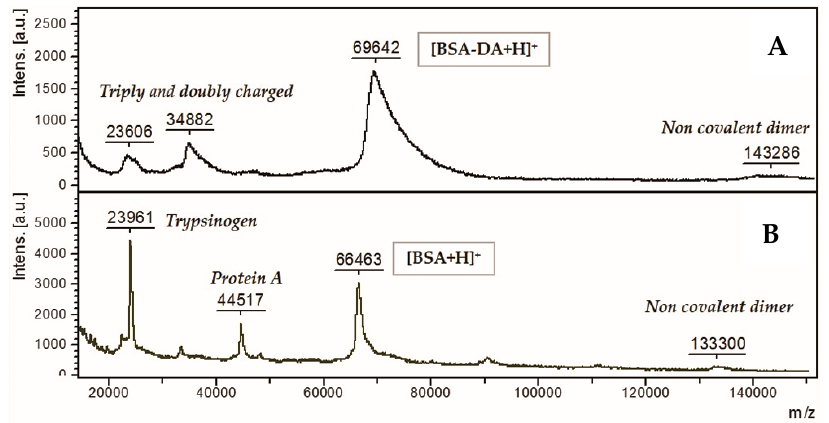
Figure 1. Matrix-assisted laser desorption/ionization (MALDI)-time of flight (TOF) spectra of ( A ) bovine serum albumin-dopamine (BSA-DA) and ( B ) BSA protein, protein A and trypsinogen.